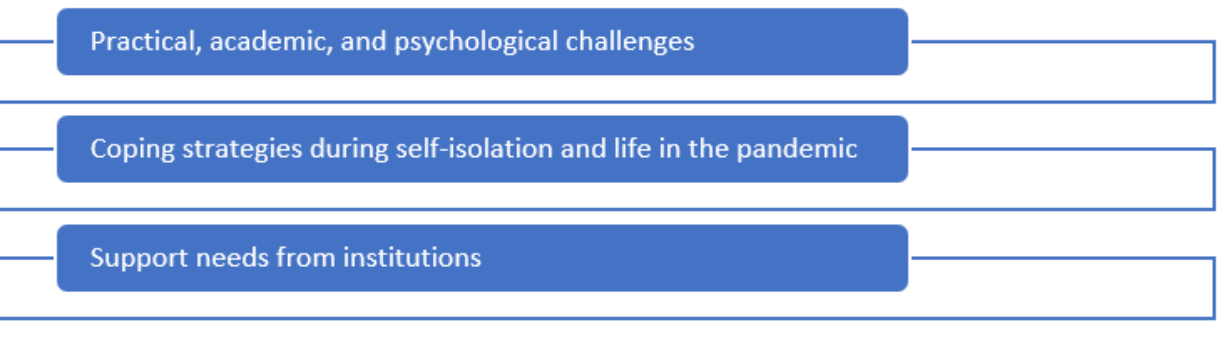
Figure 1. Key themes identified .